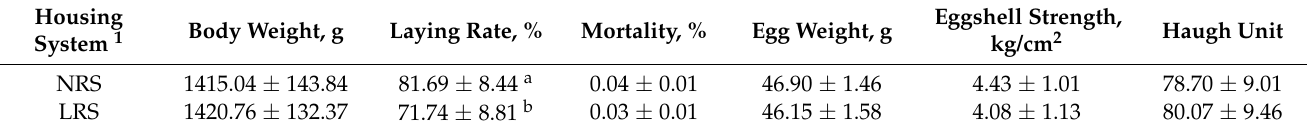
Table 1. Effects of two housing systems on the production performance of hens from 32 to 40 weeks of age. Housing